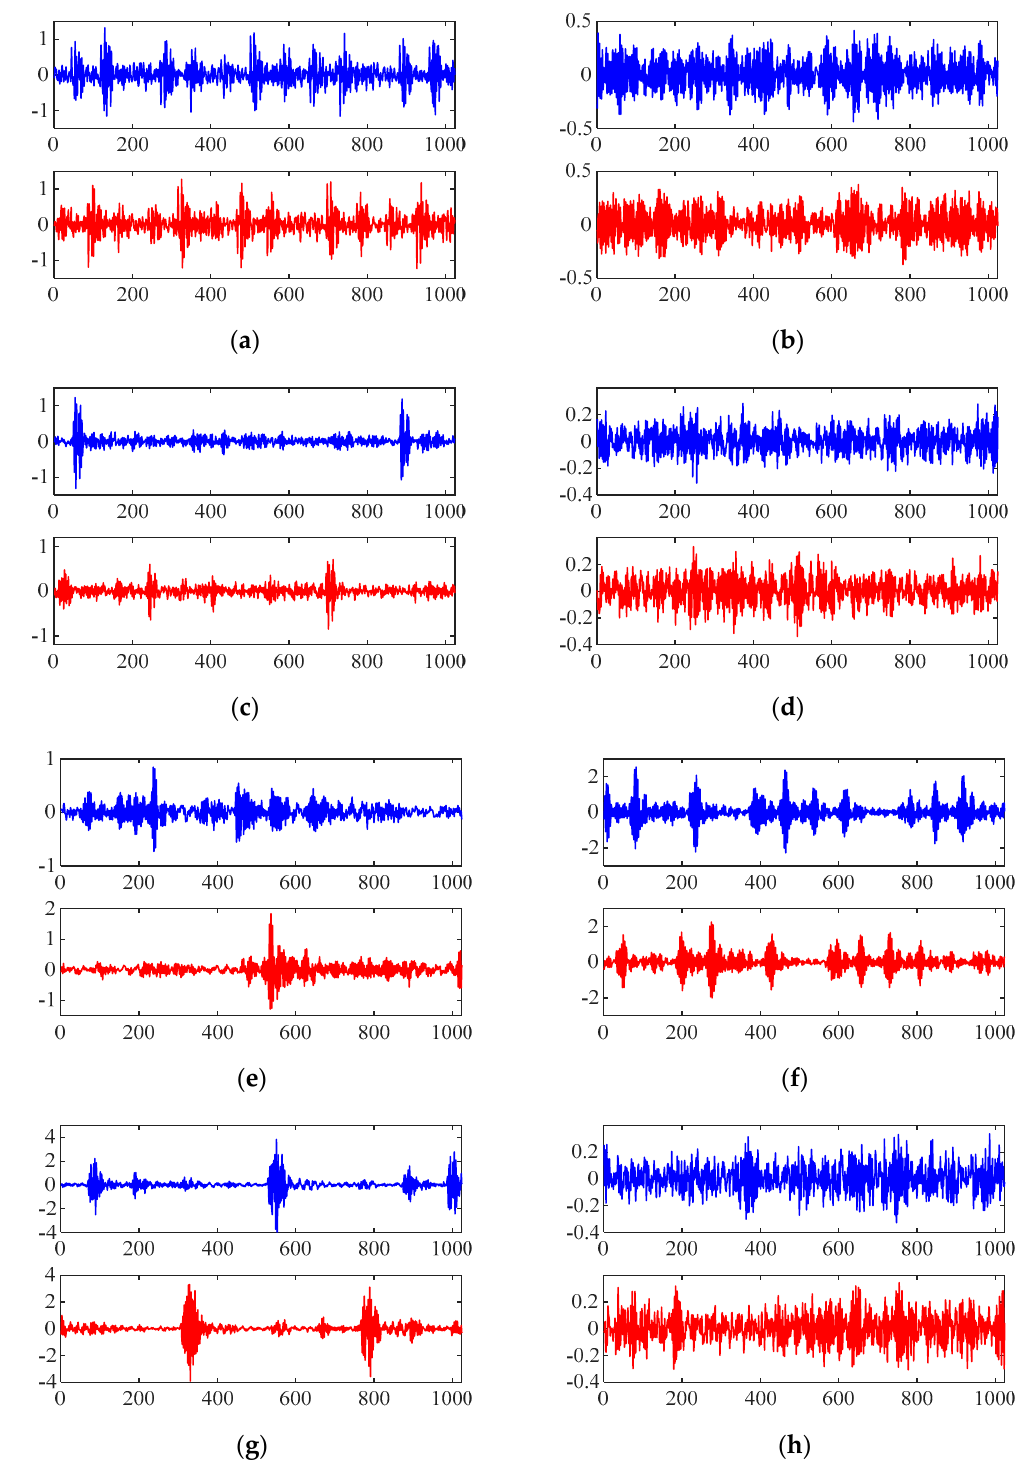
Figure 13. Comparison of real data (blue) and generated data (red) for each fault type: ( a ) Label 1; ( b ) Label 3; ( c ) Label 4; ( d ) Label 5; ( e ) Label 6; ( f ) Label 7; ( g ) Label 8; and ( h ) Label 9.